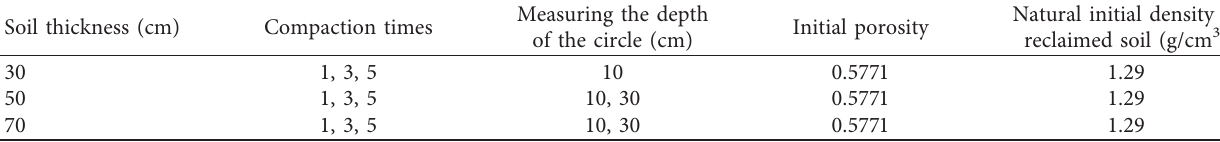
Table 4: Compaction numerical simulation parameters.